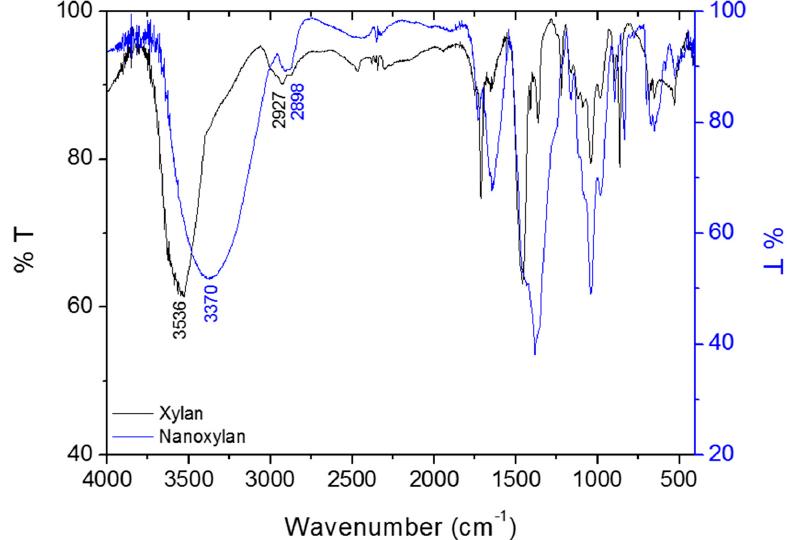
Figure 6. Average size of the nanoxylan particles evaluated over a 12-month period.